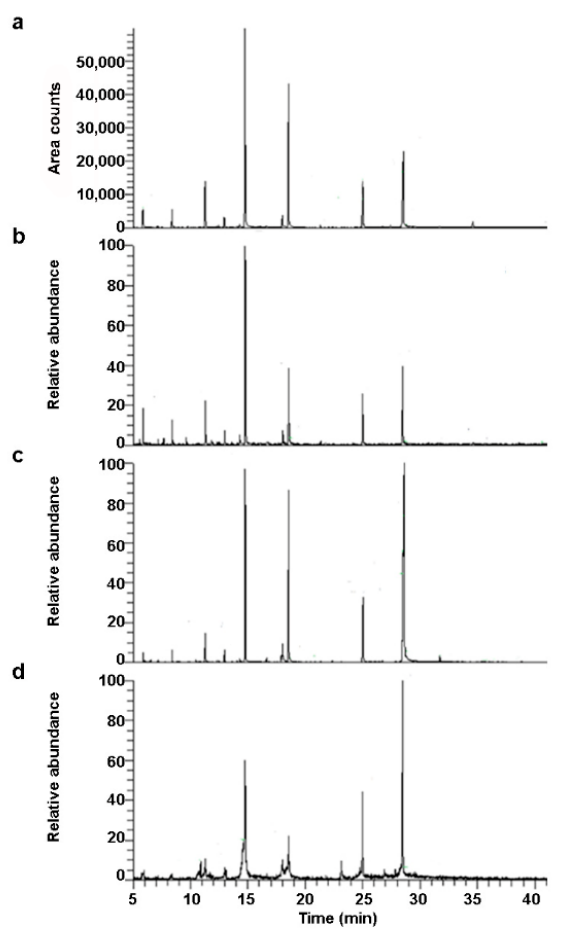
Figure 2. GC-MS XICs (ion 117 m/z , time window 5–40 min) related to the analysis of milk samples extracted with solvent from bovine milk ( a ), goat milk ( b ), soy milk ( c ), and rice milk ( d ). Each milk showed a specific chromatographic profile. The lipids identified using the NIST mass spectral library are listed in Table 1. Table 1. List of lipids identified by GC-MS in the TMS-derivatized milk samples.